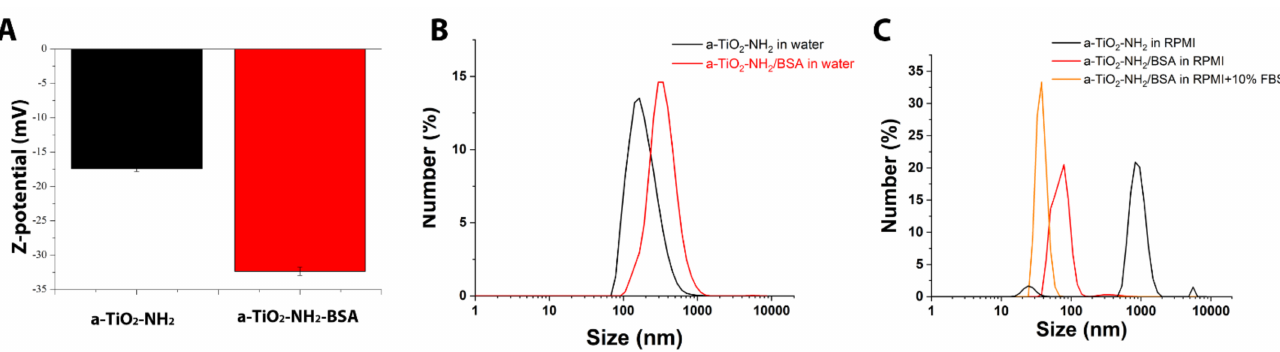
Figure 2. ( A ) Z-potential measurements in water of a-TiO 2 -NH 2 (black bar and curves) and a-TiO 2 -NH 2 /BSA (red bar and curves); Dynamic light scattering measurements in number (%) ( B ) in water and ( C ) in cell culture medium RPMI and complete cell culture medium (for TiO 2 -NH 2 /BSA only, orange